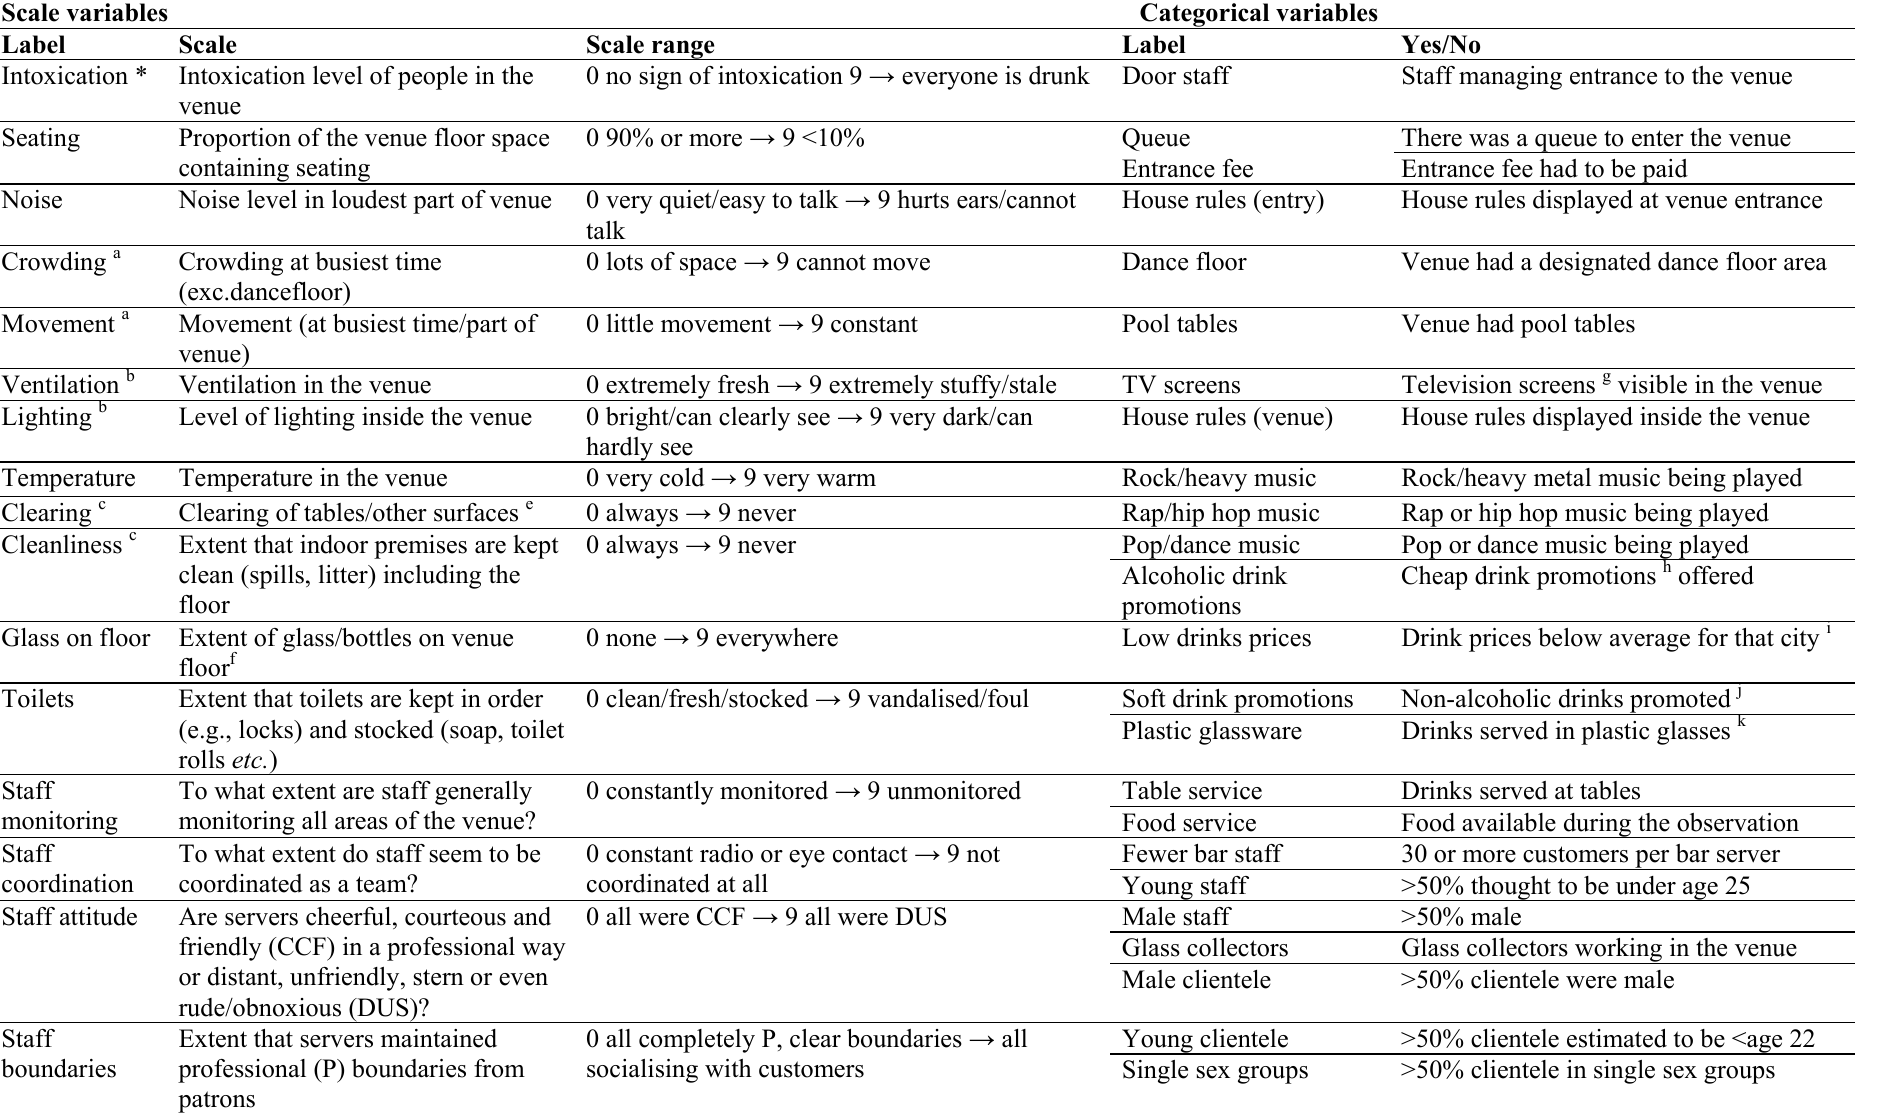
Table A1. Description of observational schedule measurements used in